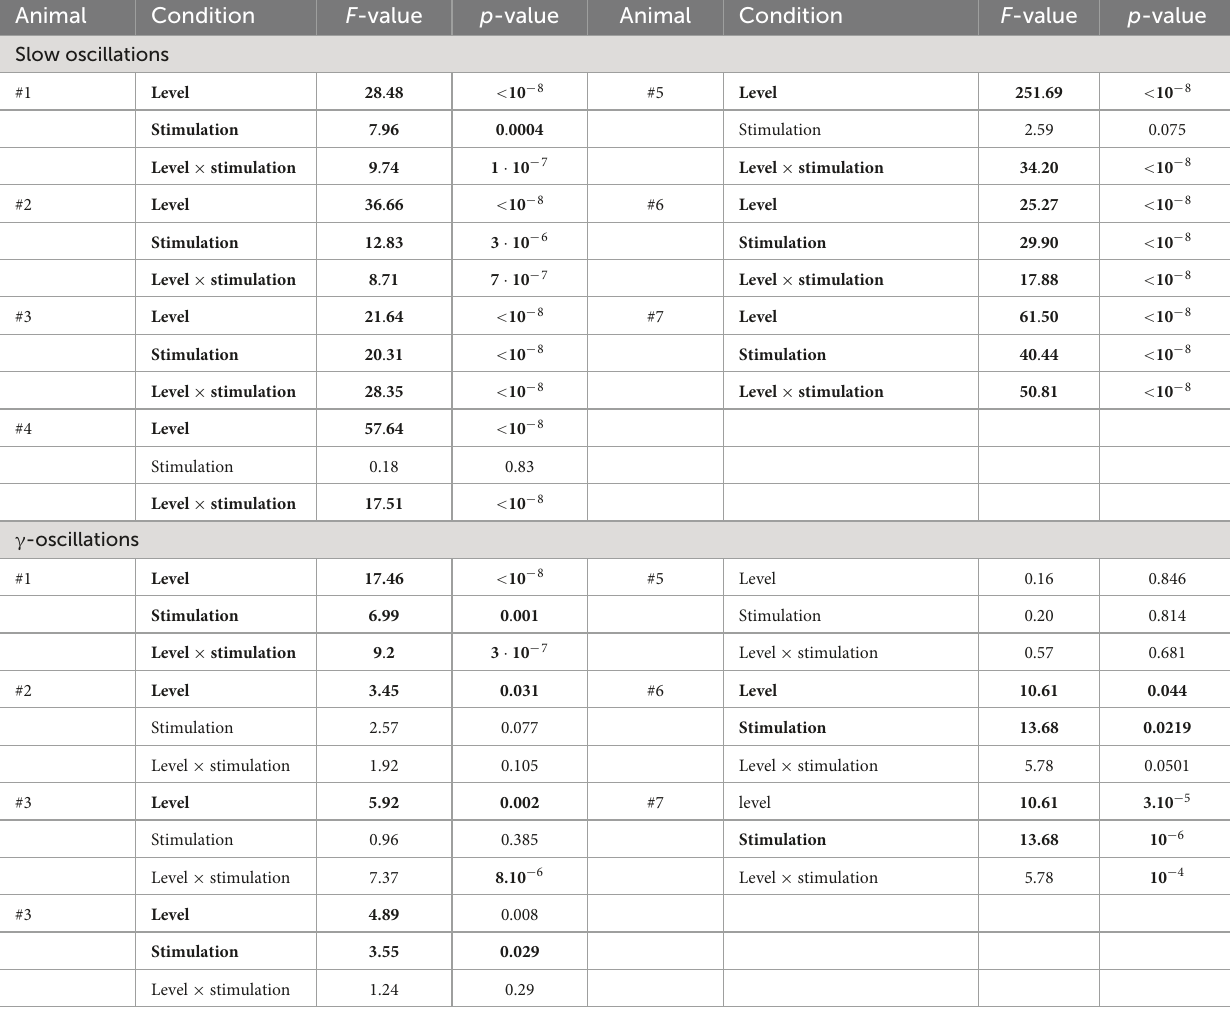
TABLE 2 Single animal factors in slow and γ -oscillations. Animal Condition F -value p -value Animal Condition F -value p